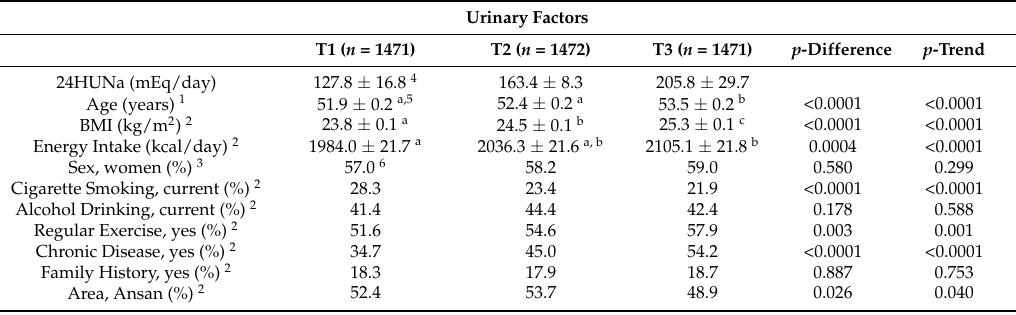
Table 2. General characteristics according to 24 h estimated urinary factors obtained with the Tanaka formula in sample